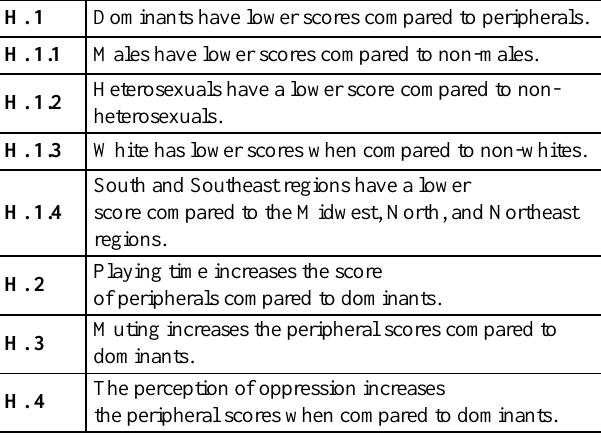
Table 1: Research hypotheses, based on CES-D and their